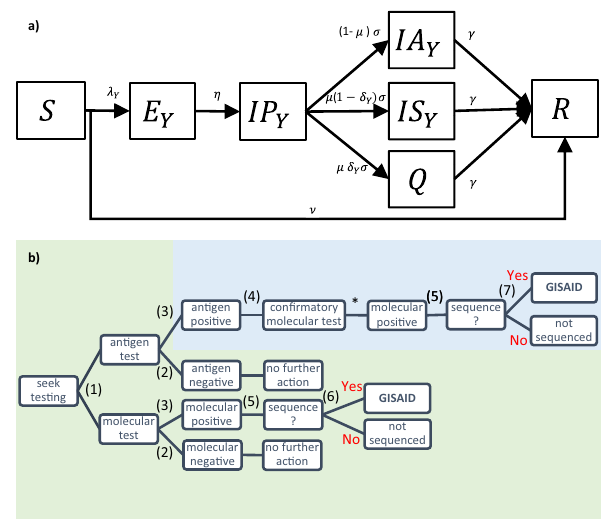
Fig. 4 | Transmission model and reconstruction of the SARS-CoV-2 reporting process in Italy. a Simpli fi ed fl ow diagram of the compartmental model used to reproduce the dynamics of the discordant variant M234I-A376T and the con- cordant variants A220V, Alpha, and other variants, in Veneto and the rest of Italy. , Susceptible individuals (S compartment) are infected at rate λ Y = β Y ð IP Y + IA Y + IS Y Þ S 0 where subscript Y refers to the virus variants (M234I-A376T, A220V, Alpha, other variants).Upon infection, thelatencyperiod( E Y compartment) lasts for an average of 1 = η days after which individuals are infectious but asymptomatic ( IP Y compart- ment)foranaverageof1 = σ days.Weassumethataproportion(1 (cid:2) μ )ofinfections remain asymptomatic ( IA Y compartment) whilst the remaining proportion ( μ ) developsymptoms;ofthesesymptomaticindividualsweassumethataproportion (1 (cid:2) δ Y ) are not detected by surveillance ( IS Y compartment) and the remaining proportion δ Y isdetected,reportedandisolates( Q compartment).Afteranaverage infectious period of 1 = γ days individuals recover and test negative ( R compart- ment).Susceptibleindividualsarevaccinated and enter the R compartment atrate ν . b DescriptionoftheItalytestingpolicy,reproducedinthecompartmentalmodel. (1) Symptomatic individuals present for diagnosis with either an antigen or mole- cular test. (2) Negative test results warrant no further action and individuals con- tribute to transmission (IS compartment). (3)Individuals witha positive antigen or molecular test result isolate until their recovery (Q compartment, 100% com- pliance).(4)Positiveantigentestsareadditionallycon fi rmedwithamoleculartest. (5) A random proportion of molecular-positive samples are selected for genomic surveillanceandreportedinGISAID.(6)Inthegreenpathway,bothdiscordantand concordantvariantsampleswillbereportedinGISAID.(7)Inthebluepathway,only concordant variant samples will returna positive antigen resultand be reported in GISAID.As positive antigencasesarecon fi rmed by moleculartests, the probability of reporting a concordant variant in GISAID is independent of the test adminis- tered.Forthediscordantvariant,theprobabilityofreportinginGISAIDdependson the probability that the initial test is molecular. *Antigen-positive samples are assumed to also be